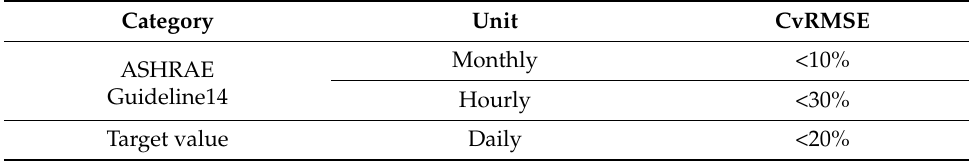
Table 3. Evaluation criteria for predictive models.